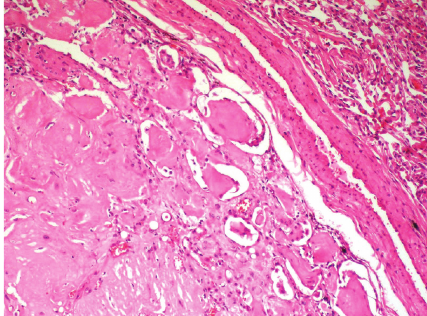
Figure3:AmicroscopicviewofPHG.Alesionwithregularmargins containing very hypocellular, keloid-type coarse collagen. HE ×